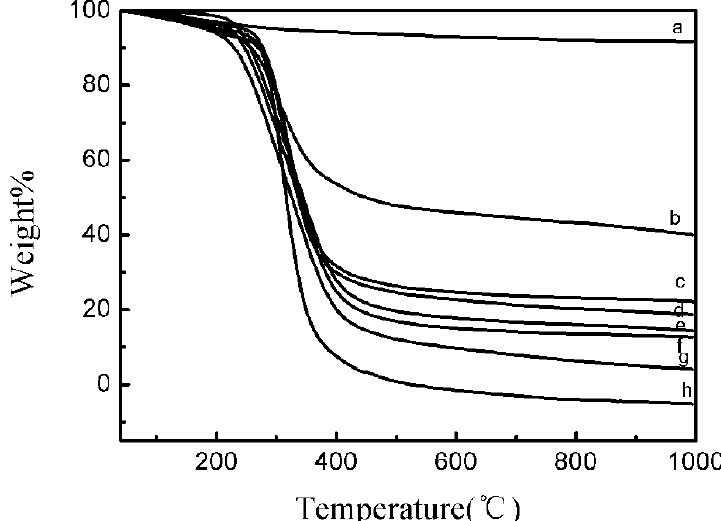
, (b) HAP-5, (c) HAP-10, (d) HAP-20, (e) 2